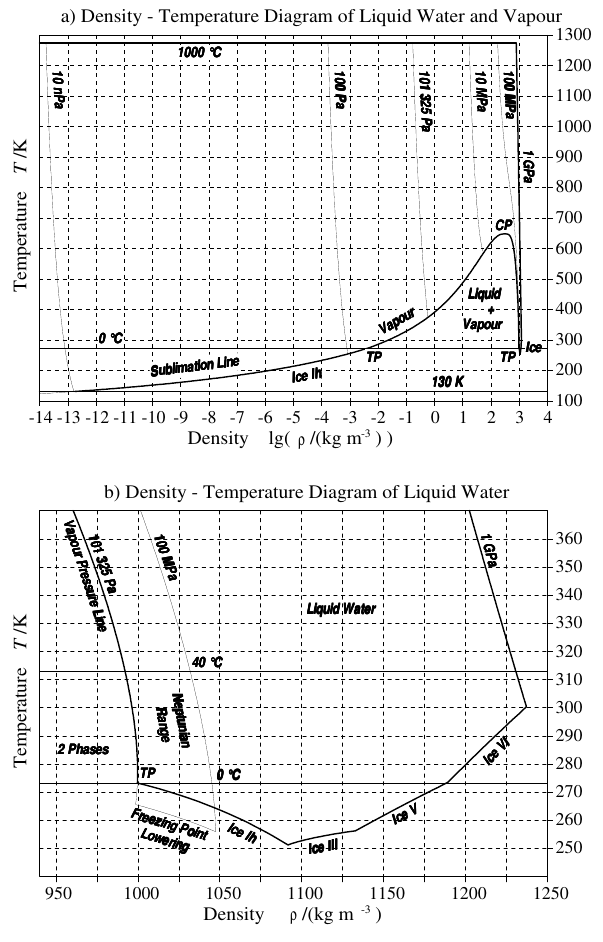
Fig. 1. Panel (a) Validity region (bounded by bold lines) of the IAPWS-95 Helmholtz potential for fluid water with isobars as indi- cated. Panel (b) Magnified view of the small region corresponding to the standard oceanographic (“Neptunian”) range. TP: triple point gas-liquid-solid, CP: critical point. The deviation of the vapour- pressure line from the 101325Pa isobar in the liquid region is be- low the graphical resolution of panel (b). Freezing-point lowering occurs with the addition of sea salt. To deal with this effect in the case of seawater, the extension of the pure water properties into the metastable liquid region just above the line marked “Freezing Point Lowering” is required.